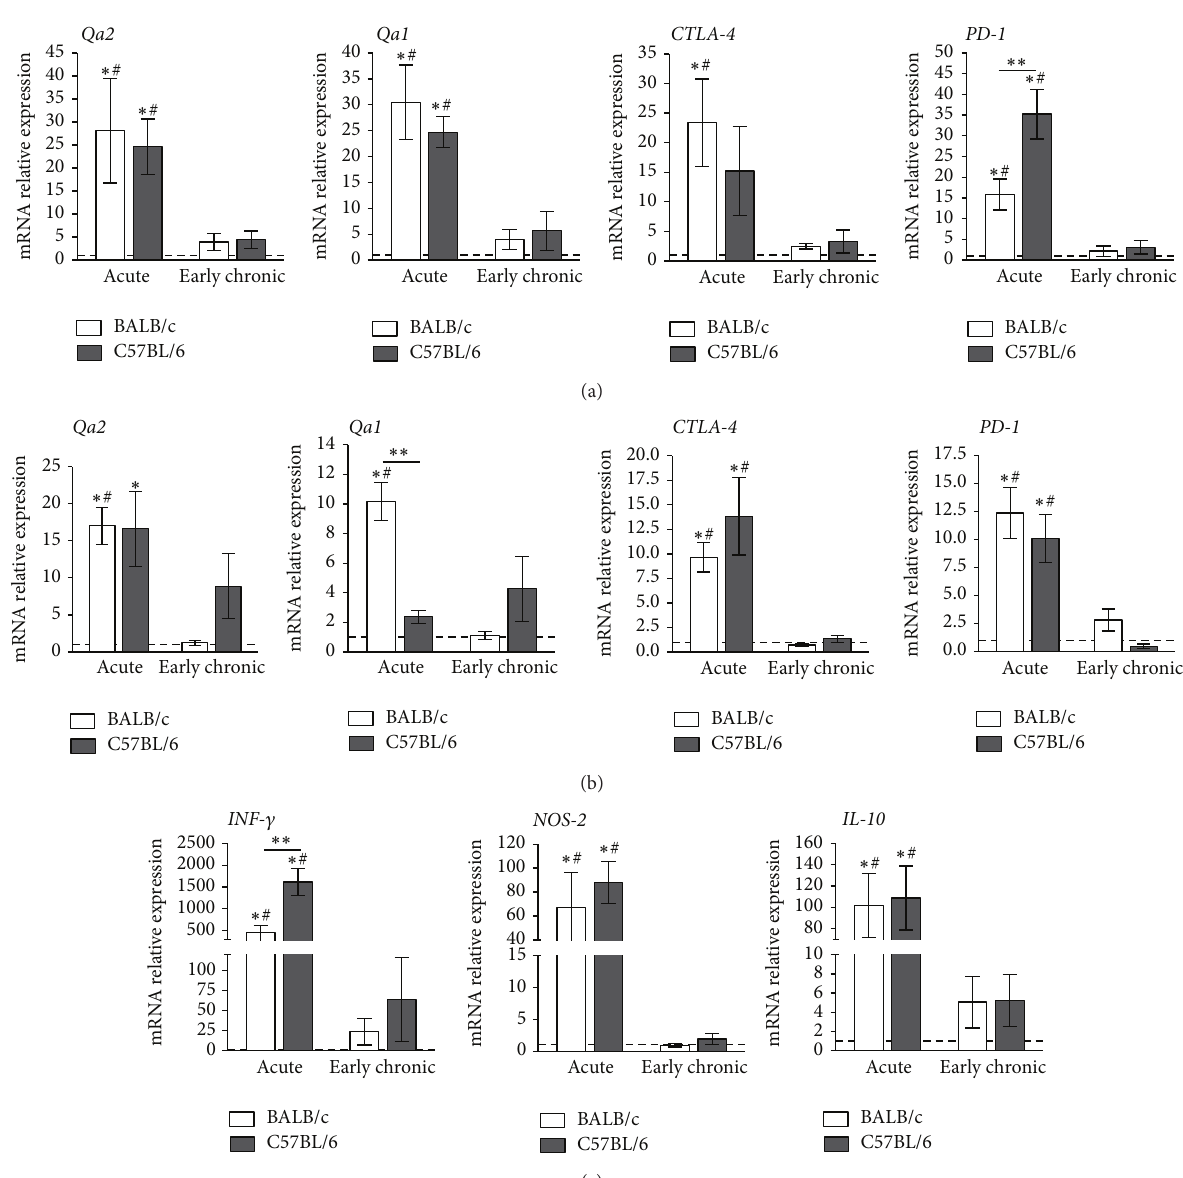
Figure 3: Transcriptional level in the heart and esophagus of T. cruzi infected mice. Transcript levels for immunomodulatory genes were measured by qRT-PCR in whole heart (a) and esophagus (b) homogenates obtained from infected mice at days 24 and 60 after infection for acute and early chronic infections, respectively. Transcriptional levels for INF- 𝛾 , NOS-2, and IL-10 were measured by qRT-PCR in whole heart homogenate (c). Uninfected mice are represented by dashed lines. The results are expressed as relative expression. The data represent the mean ± SEM ( 𝑛 = 6 mice/group). ∗ 𝑃 < 0.05 indicating statistical significance compared with noninfected mice. # 𝑃 < 0.05 , comparison between acute and early chronic infections. ∗∗ 𝑃 < 0.05 , comparison between BALB/c and C57BL/6 infected